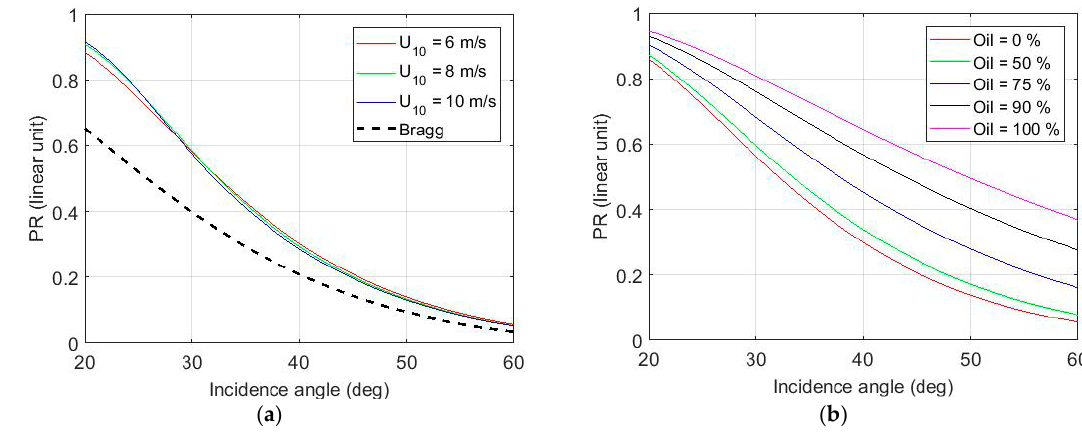
Figure 8. Bragg theory and U-WCA scattering model. Polarization Ratio (PR) as a function of the incidence angle ( a ) for various wind speeds and ( b ) for various oil contents using the Bruggeman formula to estimate the effective dielectric constant of an oil-in-water mixing with a wind speed of 5 m/s. Values of the dielectric constant are taken from Table 1.